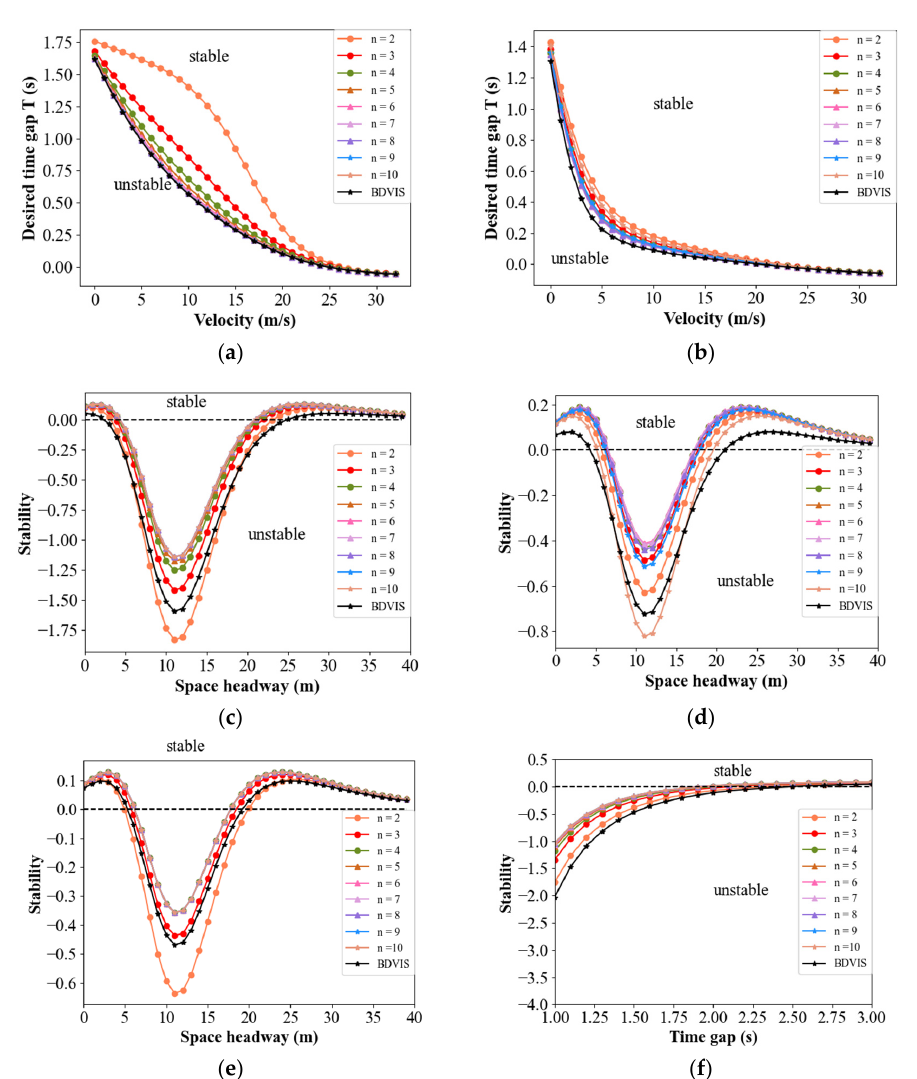
Figure 5. The stability for vehicles under the BDVIS and different positions of the vehicles under the DMVIS. ( a ) Relationship between platoon length and stability in IDM when β 1 = 0.5 and β 2 = 0.1; ( b ) Relationship between platoon length and stability in IDM when β 1 = 0.5 and β 2 = 0.3; ( c ) Relationship between the position of the vehicles and stability in FVD when β 1 = 0.5 and β 2 = 0.0; ( d ) Relationship between the position of the vehicles and stability in FVD when β 1 = 0.4 and β 2 = 0.3; ( e ) Relationship between the position of the vehicles and stability in OV model when β 1 = 0.5 and β 2 = 0.0;( f ) Relationship between the position of the vehicles and stability in ACC model when β 1 = 0.5 and β 2 = 0.0.